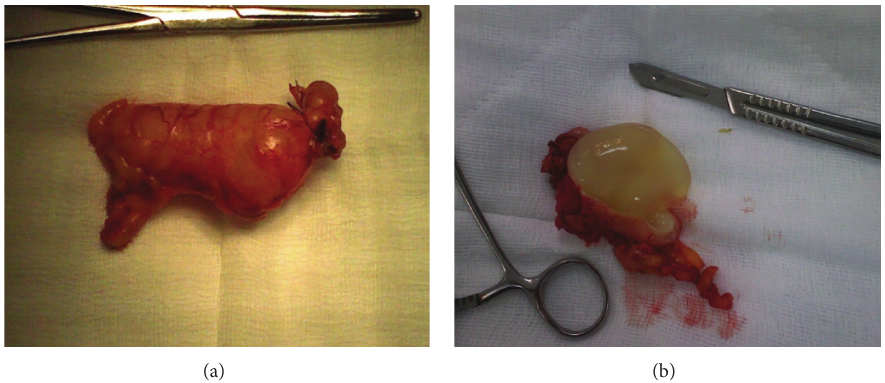
Figure 9: ((a) and (b)) The excised appendix distended with mucous (first case).